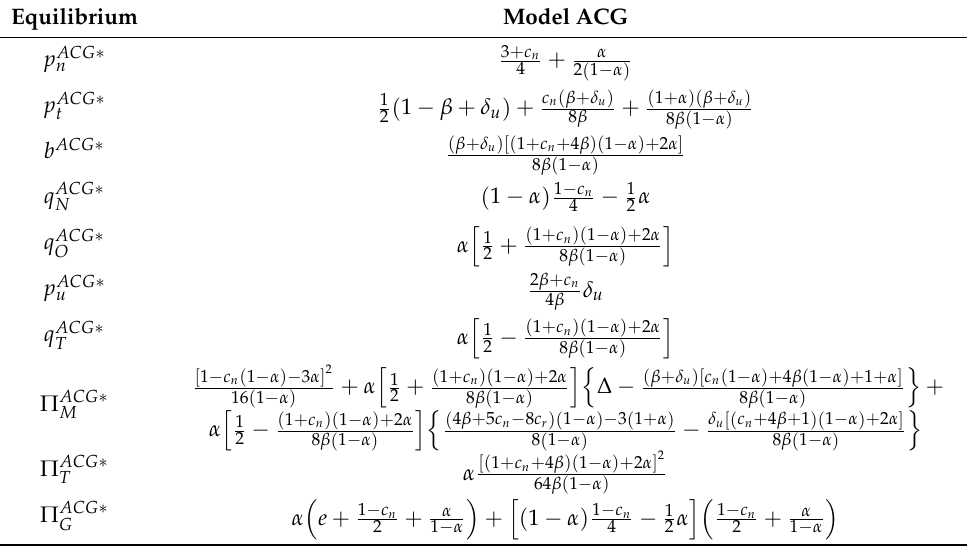
Table 11. Optimal solutions of Model ACG_III closed-loop supply